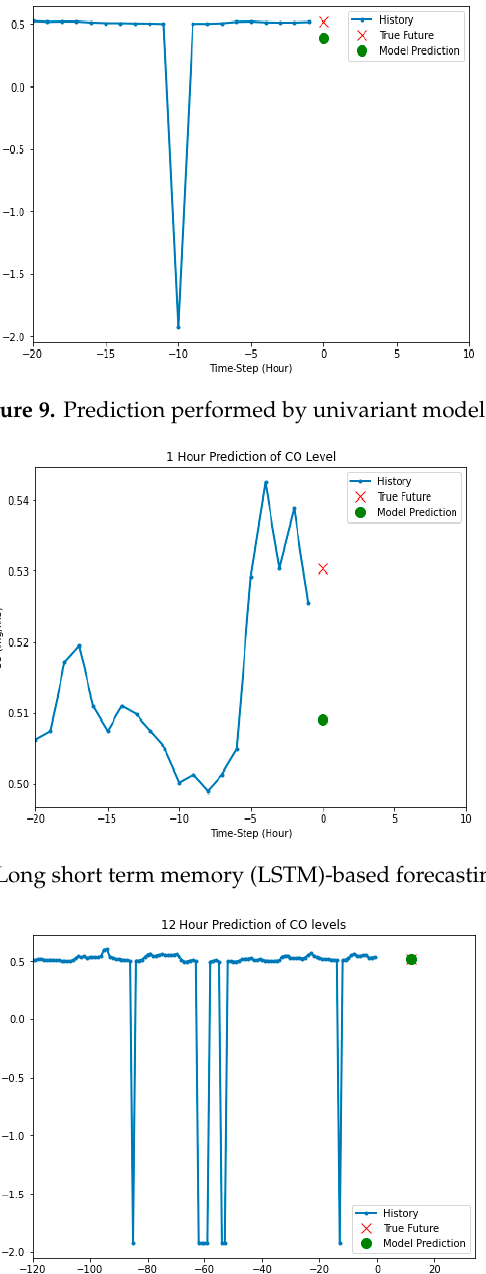
Figure 12. Offline vs. online accuracy of forecasting. 6.3. Delay Graph Delay is how much time is required for a bit of data to travel through a network from one point to another. In this project, our goal was to ensure efficiency in relation to the performance or function of a system in the best possible manner with the minimum time interval. The time required for data to move from source to destination in propose system is shown in Table 5. Sensor interval delay is defined the time after that sensor value is sent to the cloud server. The Approximately 8.25 s are required for generation and transmission of the alert message to the worker. This delay could have